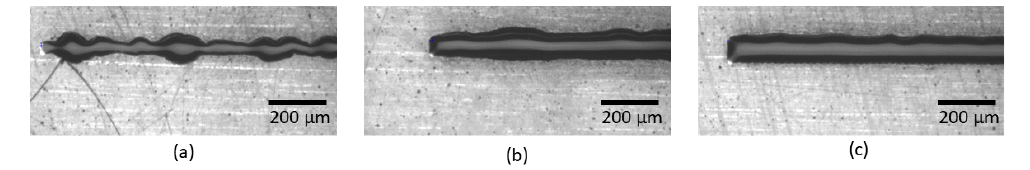
Figure 4. Single Line Tests at 45 µ m Drop Spacing with Different Track Widths: ( a ) Track Width of 50 µ m, ( b ) Track Width 80 µ m, ( c ) Track Width of 110 µ m.